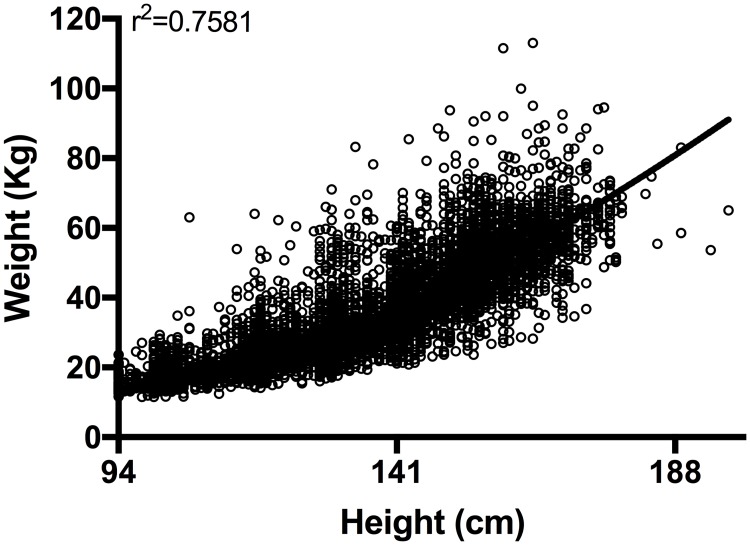
Distribution of height and weight measurements from the Mozambique study population (n = 9,827).